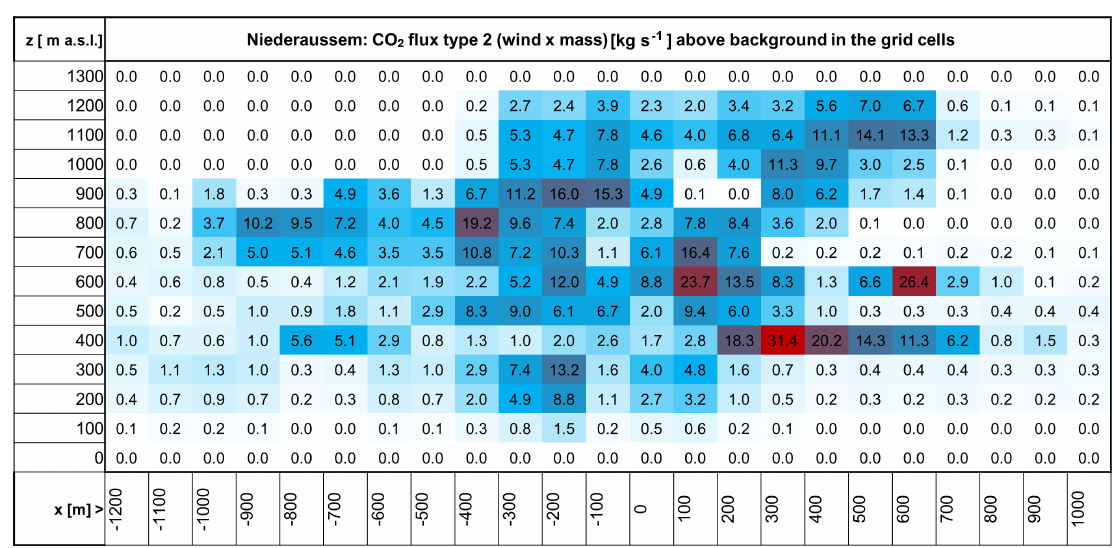
Figure 5. As Fig. 4 but for CO 2 flux 2, i.e. the product of averaged wind and mass in the individual cells. The difference between these two methods is discussed in the text and is one of the sensitivity cases as summarized in Table 3 and detailed in the